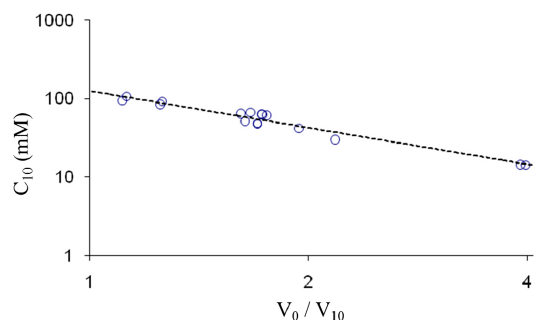
Figure 2. The concentration of network charges in PSS macrogels in 10 mM NaCl solution ( C 10 ) plotted vs. the ratio between the gel volume in pure water ( V 0 ) and in 10 mM NaCl ( V 10 ). The dashed line is a fit to the data, (cid:1829) (cid:2869)(cid:2868) (mM) = 125((cid:1848) (cid:2868) /(cid:1848) (cid:2869)(cid:2868) ) (cid:2879)(cid:2869).(cid:2873)(cid:2873)(cid:2870)